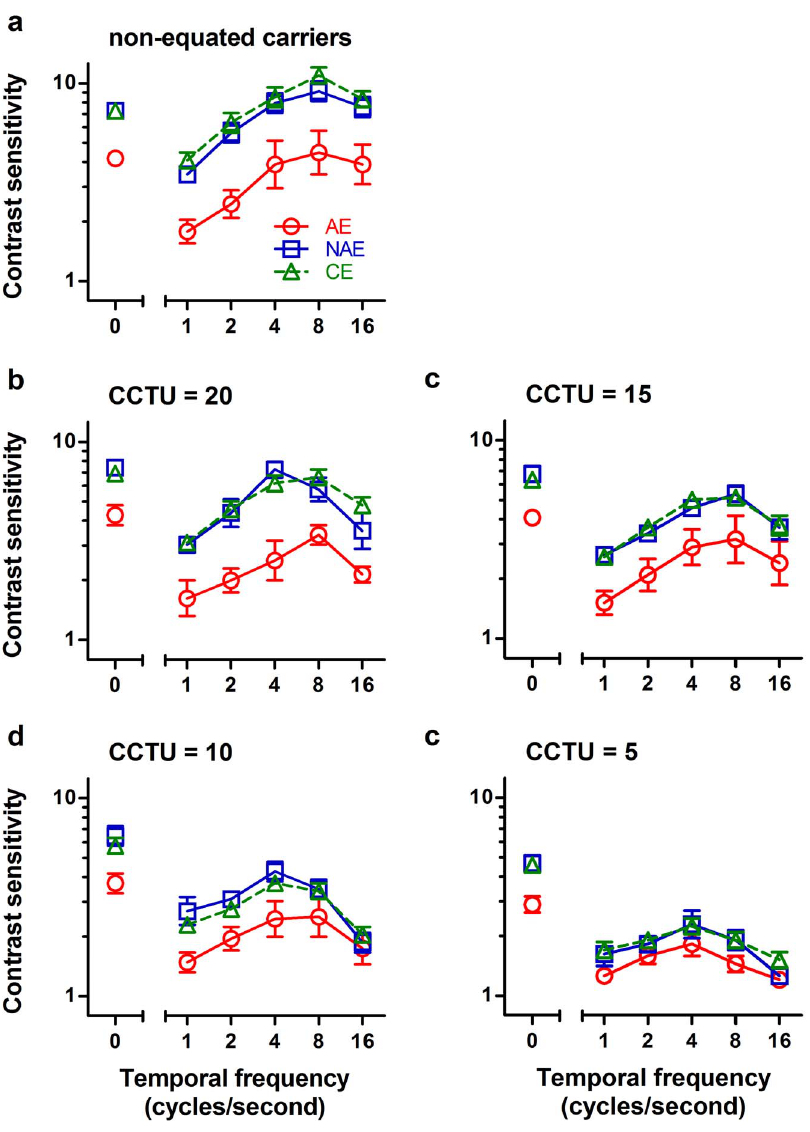
Figure 4. Average contrast sensitivity for second-order motion and static second-order stimuli for amblyopic eyes (AE, Circles), non-amblyopic eyes (NAE, Squares), and control eyes (CE, Triangles). Error bars represent one standard error of the mean. Figure 6a, it is clear that most of the AE/CE and AE/NAE ratios (5/7, except S2 and S4) were significantly (all p ’s , 0.05) lower than 1, and that most of the NAE/CE ratios (6/7, except S7) were statistically (all p ’s . 0.1) comparable to 1. As a group, the AE/CE and AE/NAE ratios were 0.71 6 0.03 and 0.72 6 0.03, respectively, significantly different from 1 (two-tailed one-sample t -test, AE/CE ratios, t 109 = 2 8.561, p , 0.001; AE/NAE ratios, t 109 = 2 8.077, p , 0.001), and the NAE/CE ratio was 1.02 6 0.03, statistically comparable to 1 (two-tailed one-sample t -test, t 109 =0.828, p = 0.409). These results suggest that the processing of second- order motion is substantially impaired in AEs of anisometropic amblyopes. In contrast, most of the NAEs are relatively spared. For comparison, the sensitivity ratios between the AEs, NAEs were shown in Figure 6b. The AE/CE and AE/NAE ratios varied